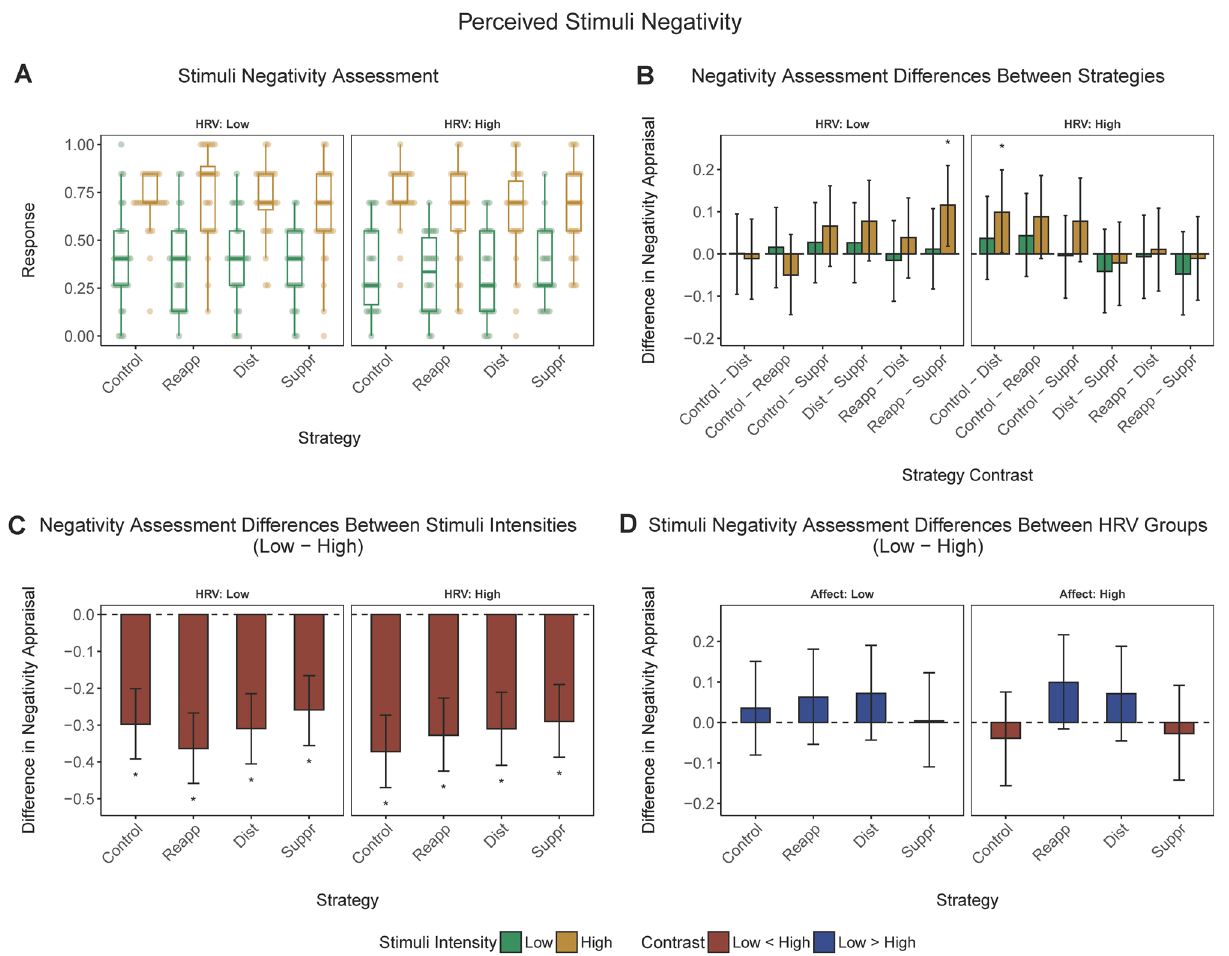
Figure 3. Perceived picture negativity . ( a ) Perceived picture negativity (median) corresponding to low or high negativity stimuli in different emotion regulation conditions and low or high baseline HRV groups. ( b ) Pairwise contrasts of the perceived picture negativity between emotional regulation conditions corresponding to low or high negativity stimuli in the low or high HRV group. ( c ) Contrasts of the perceived picture negativity between low and high negativity stimuli across emotional regulation conditions in the low or high HRV group. ( d ) Contrasts of the perceived picture negativity scores between low versus high baseline HRV groups. Behavioral responses have been rescaled to a range between 0 and 1. Error bars represent 95% CI of the corresponding estimate. *, significant